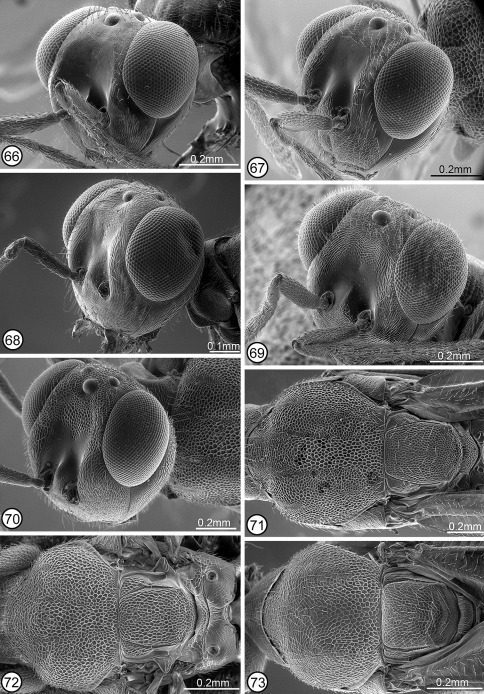
66−70 head, frontolateral view: 66 Calosota albipalpus ♀ (35) 67 Calosota acron ♀ (34) 68 Calosota metallica (30) 69 Calosota vernalis ♂ (46) 70 Calosota elongata ♀ (50). 71−73 dorsal mesosoma: 71 Calosota elongata ♀ (49) 72 Calosota aestivalis ♂ (48) 73 Calosota vernalis ♀ (47). Numbers in parentheses = CNC SEM 2009-no.